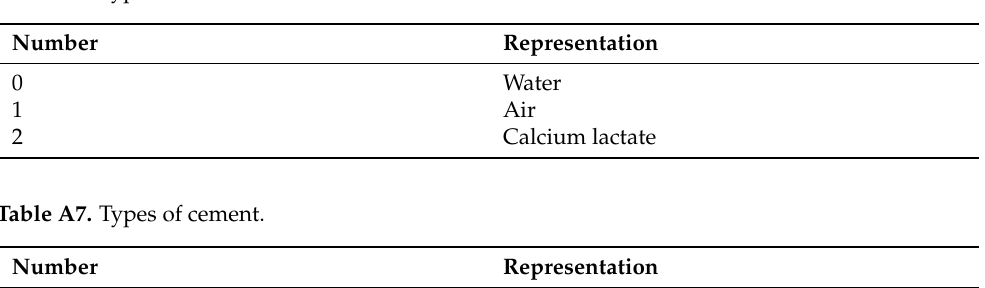
Table A6. Types of carbon sources.